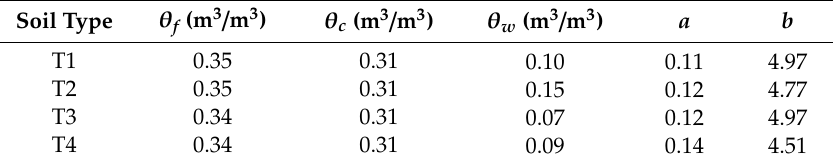
( b ) Figure 5. Results of soil water balance simulation model calibration ( a ) and validation ( b ). Note that DAP means “days after planting”.